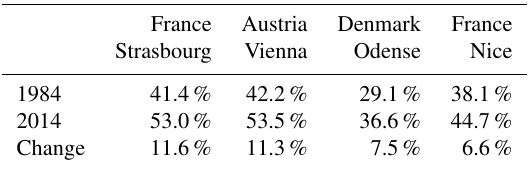
Table 1. Impervious surface fractions and changes therein during 1984–2014 (2013–2015). Imperviousness is calculated for the area covered by the urban classes in the CORINE 2012 Land Cover in- ventory (CORINE,